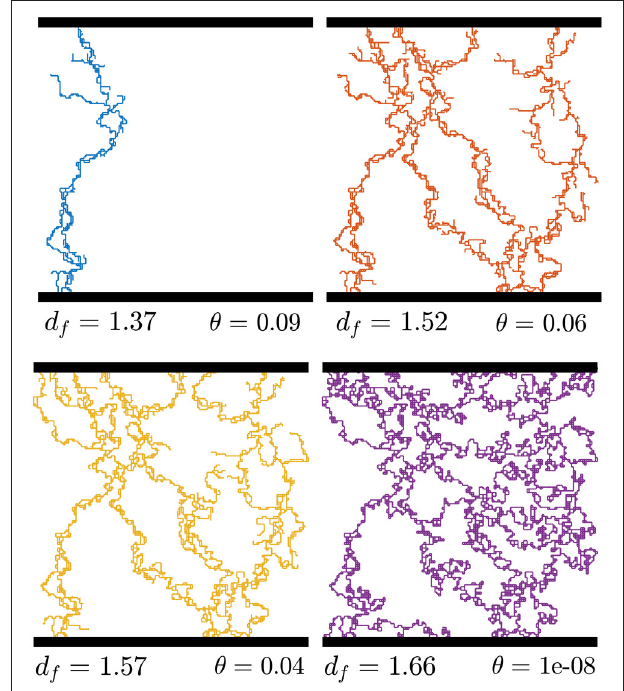
FIGURE 4 | Illustration of θ -subnetworks extracted from a percolation cluster of site occupation probability p = 0.60. Notice that the size of largest loops grow from θ = 10 − 8 to θ = 0.06 and then